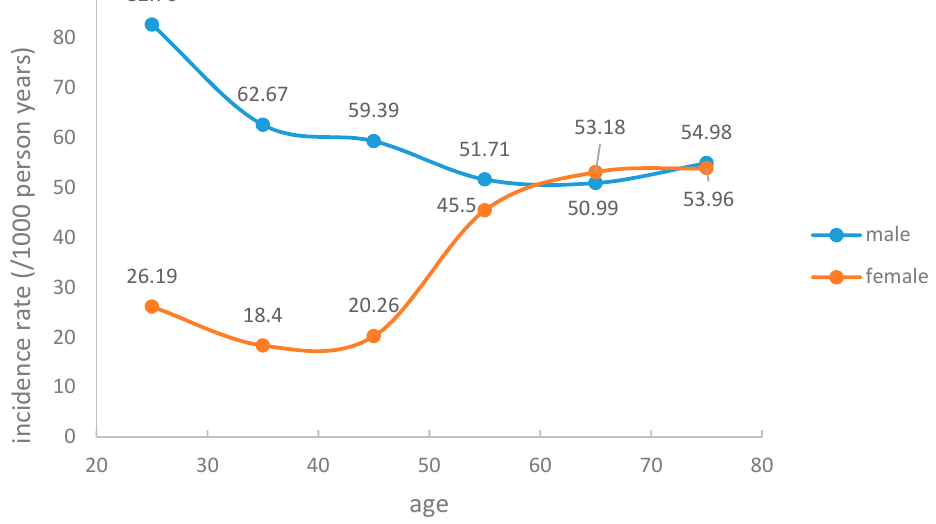
Figure 2. The incidence of hyperuricemia for both males and females.